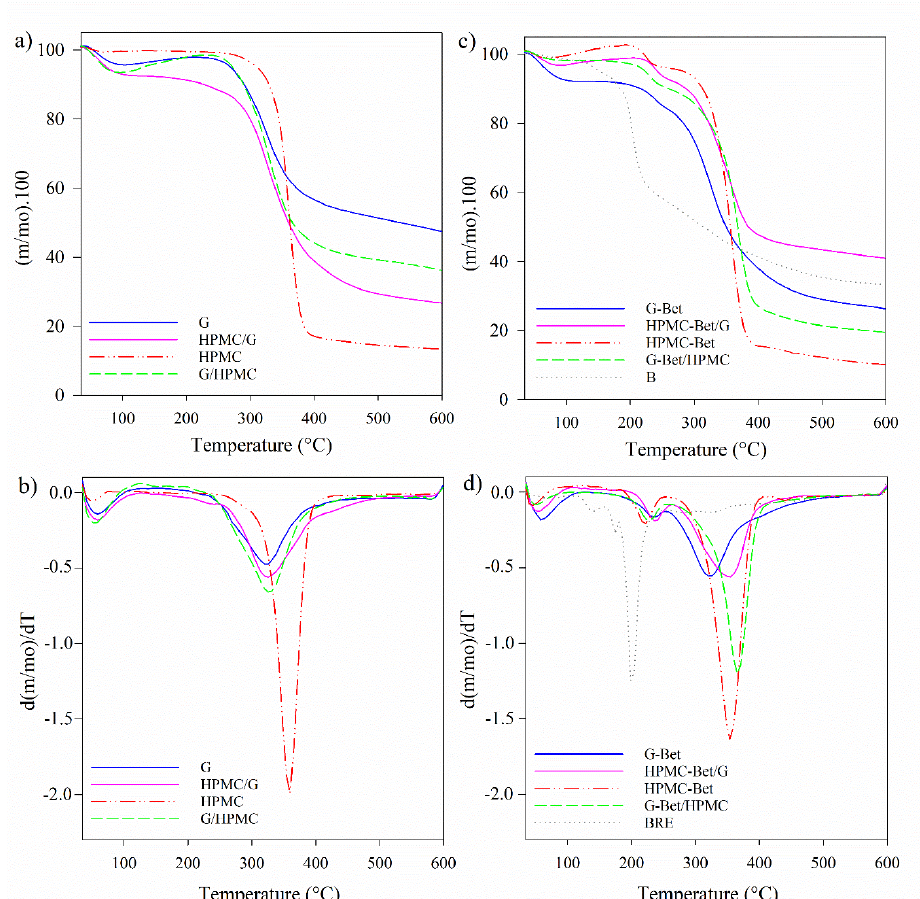
Figure 5. TGA and DTGA curves of ( a , b ) the control capsules, and ( c , d ) lyophilized beetroot extract (BRE) and active capsules. Solid and dash lines correspond to the capsule structures with higher concentrations of G and HPMC, respectively.